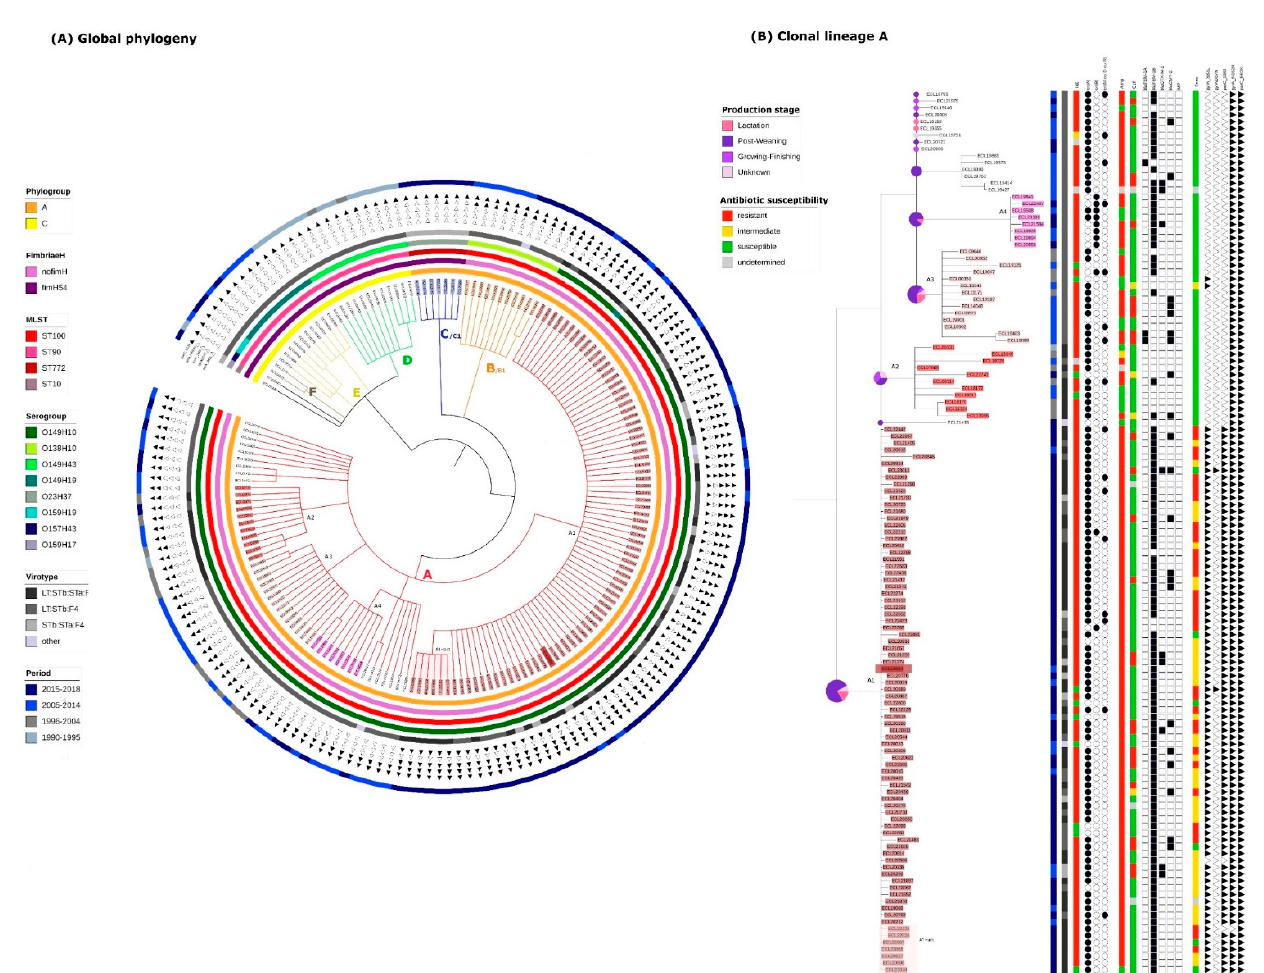
Figure 1. ( A ) Global phylogeny: Circular Tree based on SNP phylogeny. The length of the branches is not proportionate to the phylogenetic distance. Gubbins was used to eliminate the recombination signal. The total SNP number was 19,299. Each branch with a bootstrap value under 1 was collapsed. The capital letters designate each clonal lineage. Filled triangles indicate the presence of the corresponding mutation, empty triangles indicate the absence of the corresponding mutation. ( B ) Clonal lineage A (same phylogeny is used): The number associated with the letter A designates each clone. The identification name for each isolate belonging to a clone is highlighted in a specific color. Circles represent the proportion of the age of the pigs within each corresponding branch. Columns entitled Tet, Amp, Cef, Enro, represent respectively the susceptibility to tetracycline, ampicillin, ceftiofur and enrofloxacin (code for the corresponding color is available on the figure).